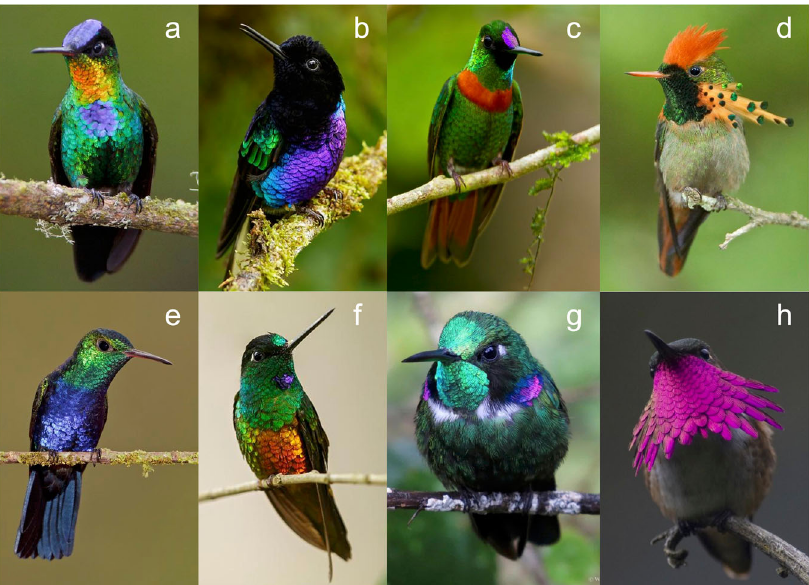
Fig. 1 Diversity of hummingbird plumage color. Photographs of males of eight of the 114 hummingbirds analyzed, showing the incredible diversity of hummingbird plumage color, including saturated blues, greens, and purples. a Panterpes insignis , b Boissonneaua jardini , c Heliodoxa aurescens , d Lophornis ornatus , e Juliamyia julie , f Coeligena bonapartei , g Schistes geoffroyi , and h Atthis ellioti . Photos reproduced with permission of: a – f Glenn Bartley; g Wilmer Quiceno; h John